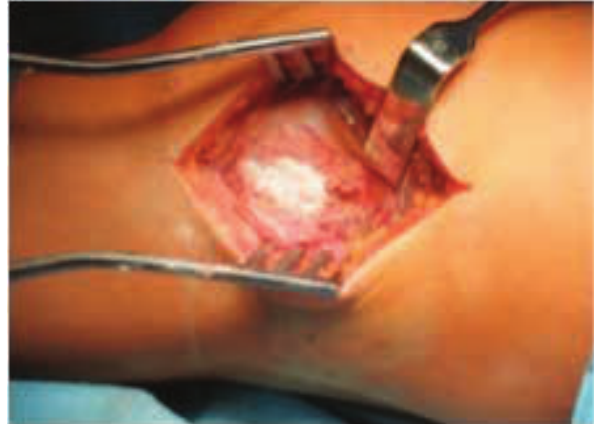
Figure 2: Intraoperative insertion of CERAMENT into the calcaneus following curettage of the giant cell tumor.